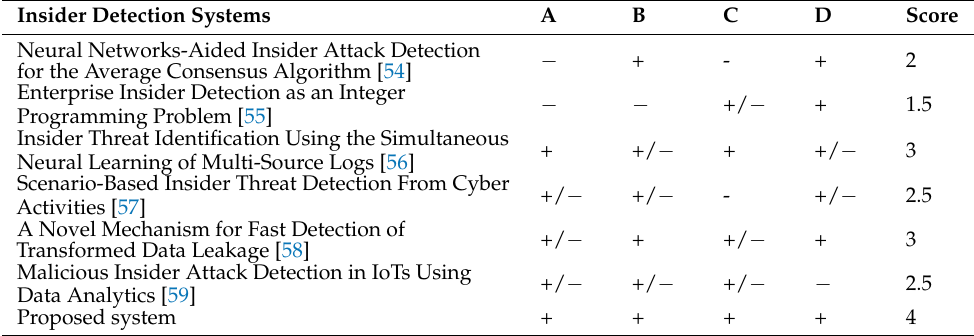
Table 17. Comparative analysis of the proposed system with existing analogs. Insider Detection